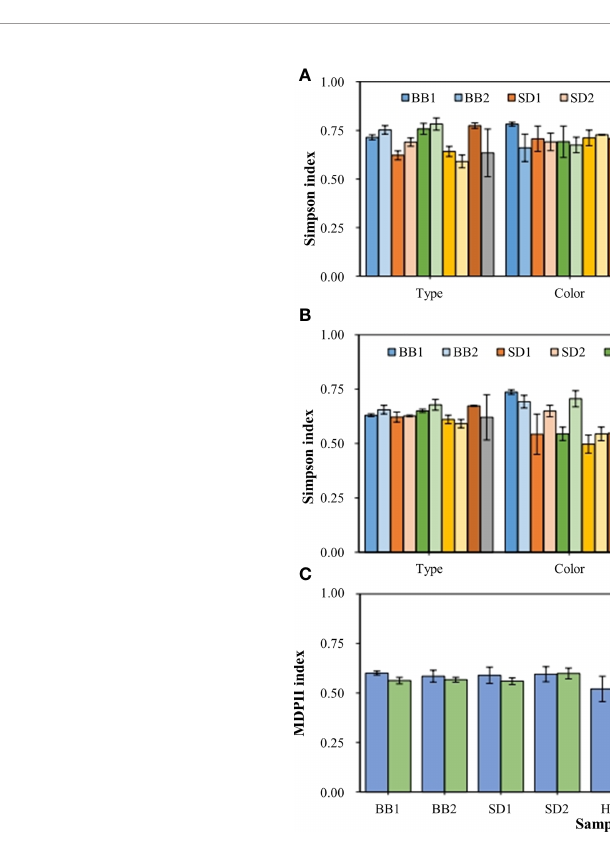
FIGURE 7 | Simpson index of MP communities in seawater (A) , sediments (B) at different sampling zones from the coastal Qingdao, including the diversity index of types, colors, shapes, and size. MP diversity integrated index (MPDII) in different sampling zones (C) . Error bars represent standard deviations of the means (n =